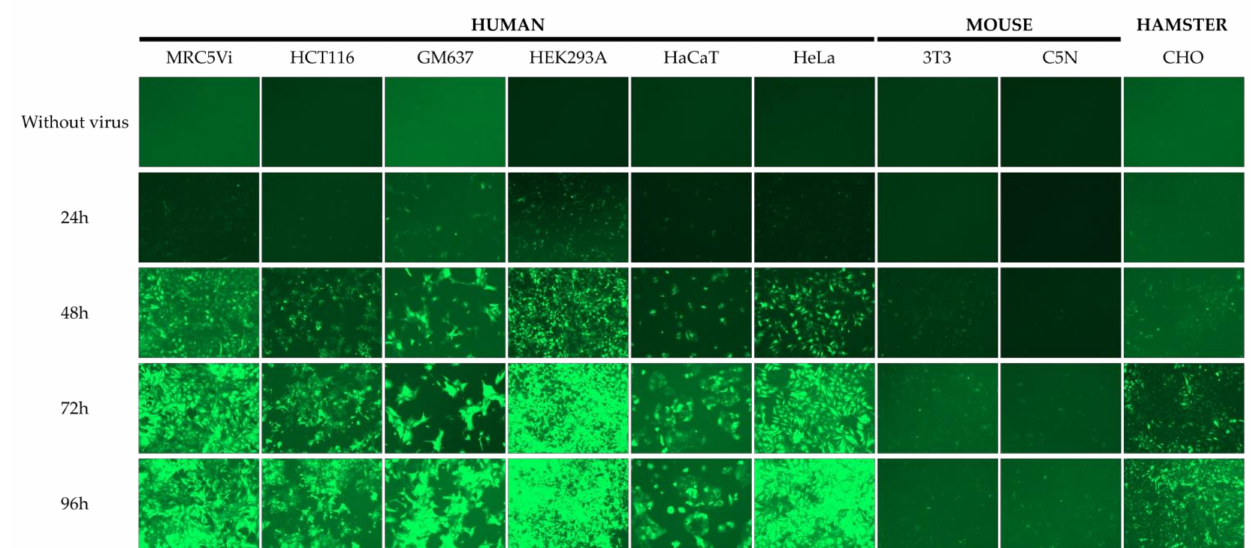
Figure 2. Transduction efficiency of various established cell lines using lentiviral transduction of an EGFP-coding plasmid. Viruses were produced in HEK293T cells using psPAX2, pCMV-VSVg, and pLJM1-EGFP with Attractene transfection reagent. The different cell lines were seeded at 100,000 cells/well in a 6-well plate and transduced 24 h later using the filtered virus stock. Using fluorescence microscopy, pictures were taken at the indicated time points (EGFP: 1800 ms, scale bar in the lower right: 400 µ